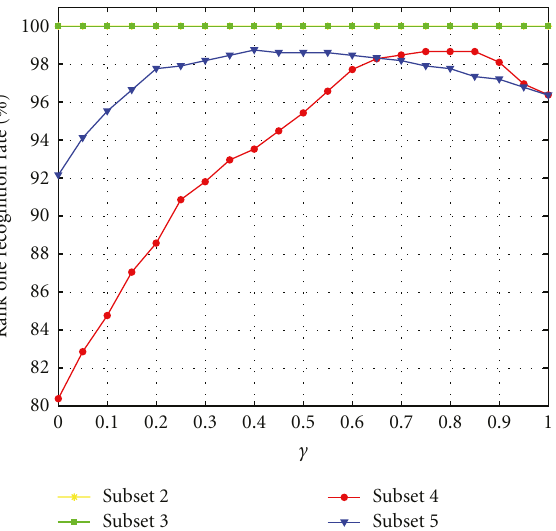
Figure 19: Rank one recognition rates (in %) obtained during the optimization of the CGFC method on the EYB database.